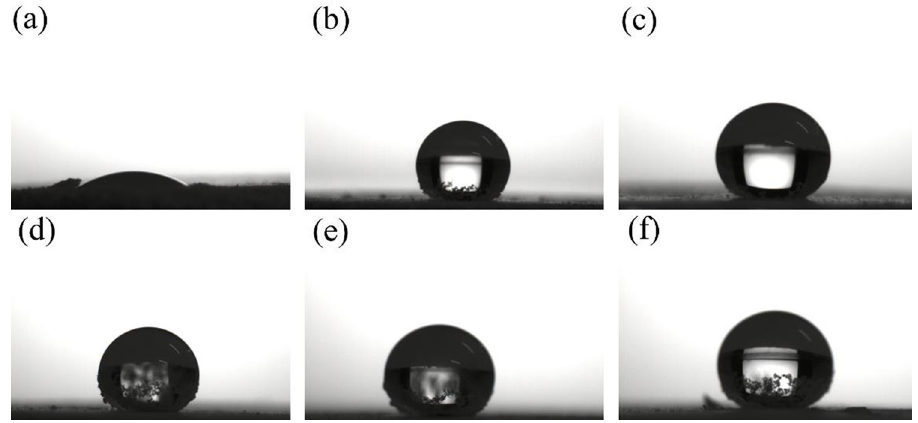
Figure 7: Static contact angle between modi fi ed nano - TiO 2 surface and water: ( a ) 0% KH570, ( b ) 5% KH570, ( c ) 10% KH570, ( d ) 15% KH570, ( e ) 20% KH570, and ( f ) 25%